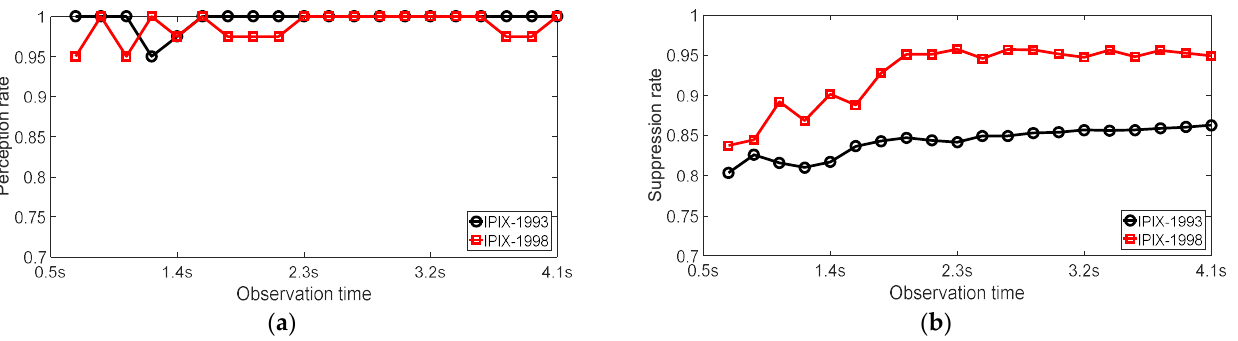
Figure 16. Quantitative indicators of the proposed correlation estimation method. ( a ) perception rate. ( b ) suppression rate.